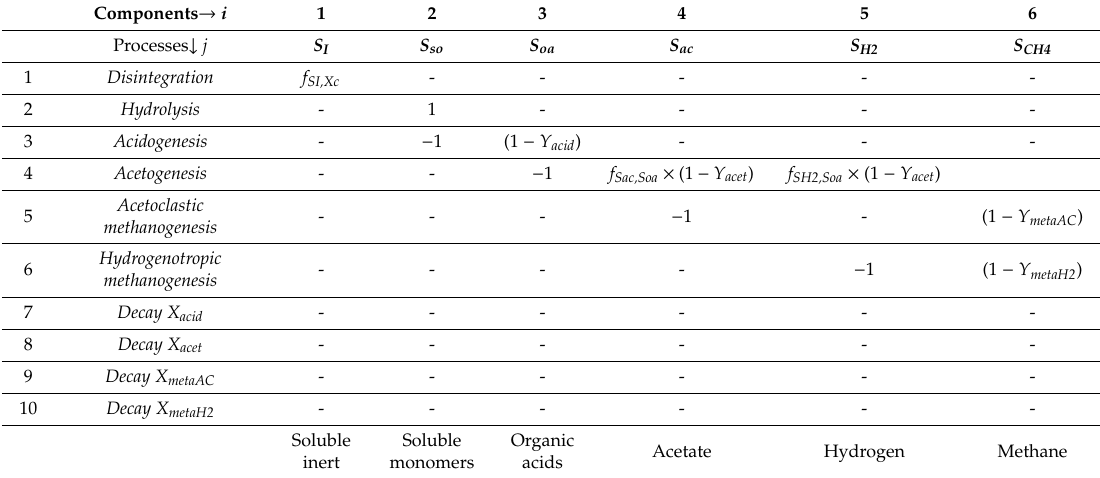
Table 1 . Biochemical coefficients ( α i , j ) for soluble components ( i = 1–6, j = 1–10).